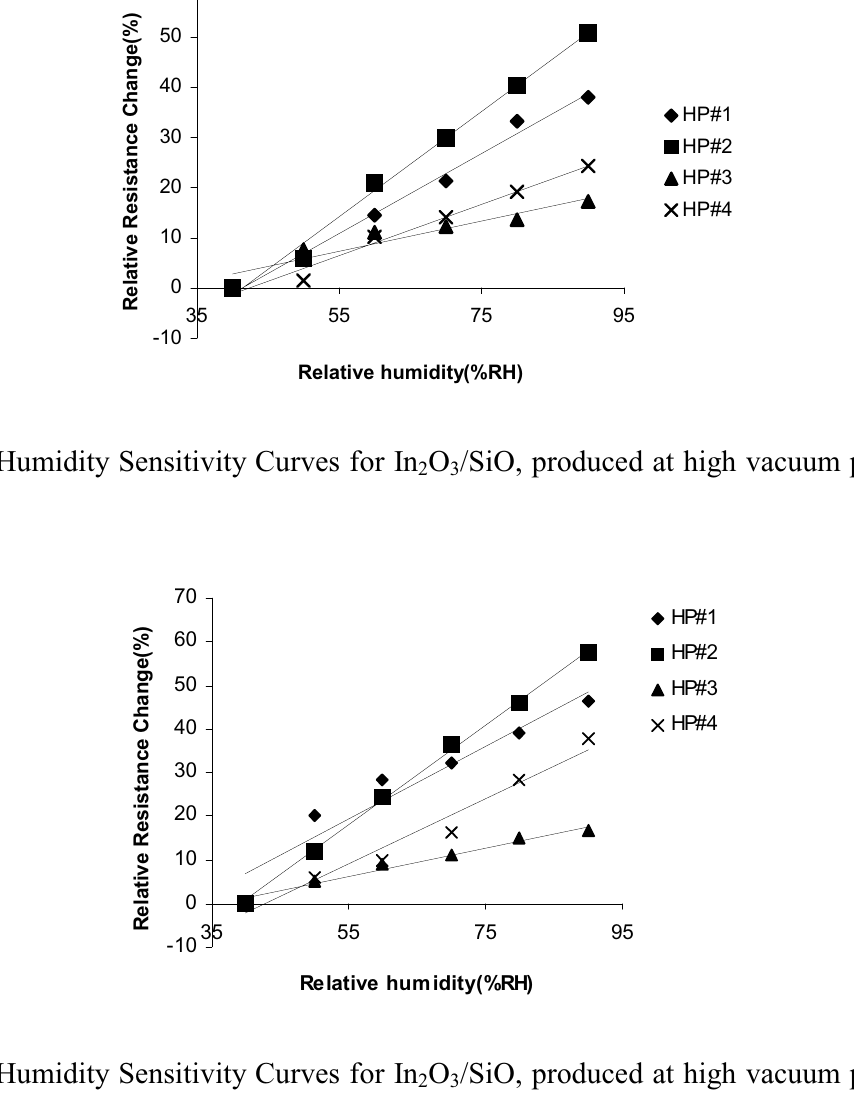
O /SiO, produced at high vacuum pressure, at 2 3